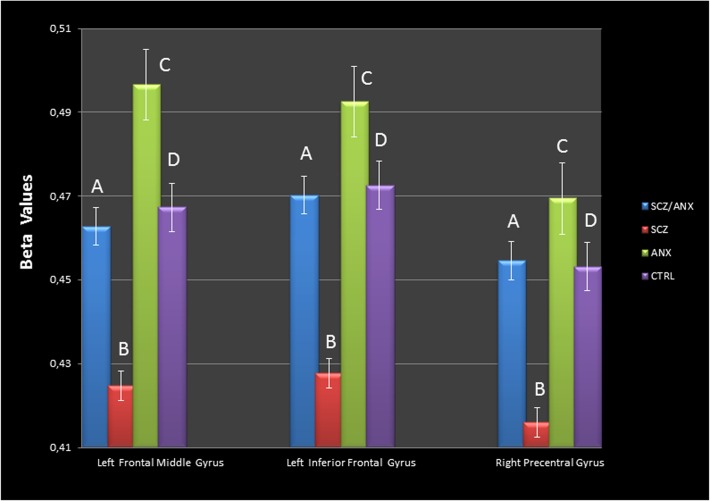

Fig. 2 shows the beta values (Parameters’ extraction) for each ROI that showed GMV differences in the main contrast.a) For the left middle frontal gyrus, significant differences (p<0.05) were observed between A-B, A-C, B-D, and B-C. b) For the left inferior frontal gyrus, significant differences (p<0.05) were observed between A-B, B-C, and B-D. c) For the right precentral gyrus, significant differences (p<0.05) were observed between A-B, B-C, and B-D.